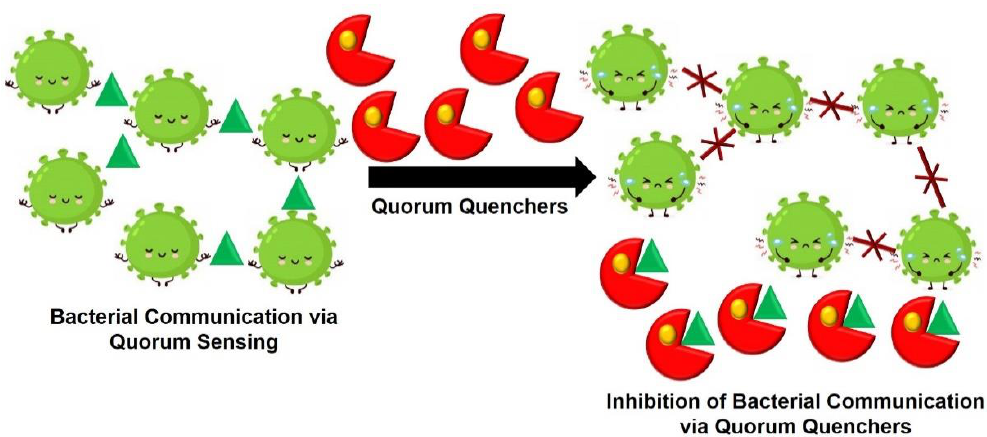
Figure 9. Quorum sensing can be blocked by producing and apply chemical analogs, which render the bacteria unable to communicate and hence pathogenicity-related expression is